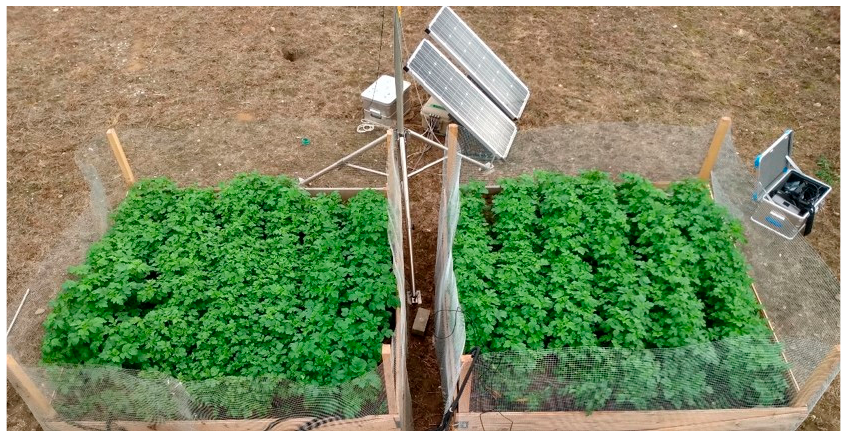
Figure 2. Picture of the boxes during the mustard experiment.